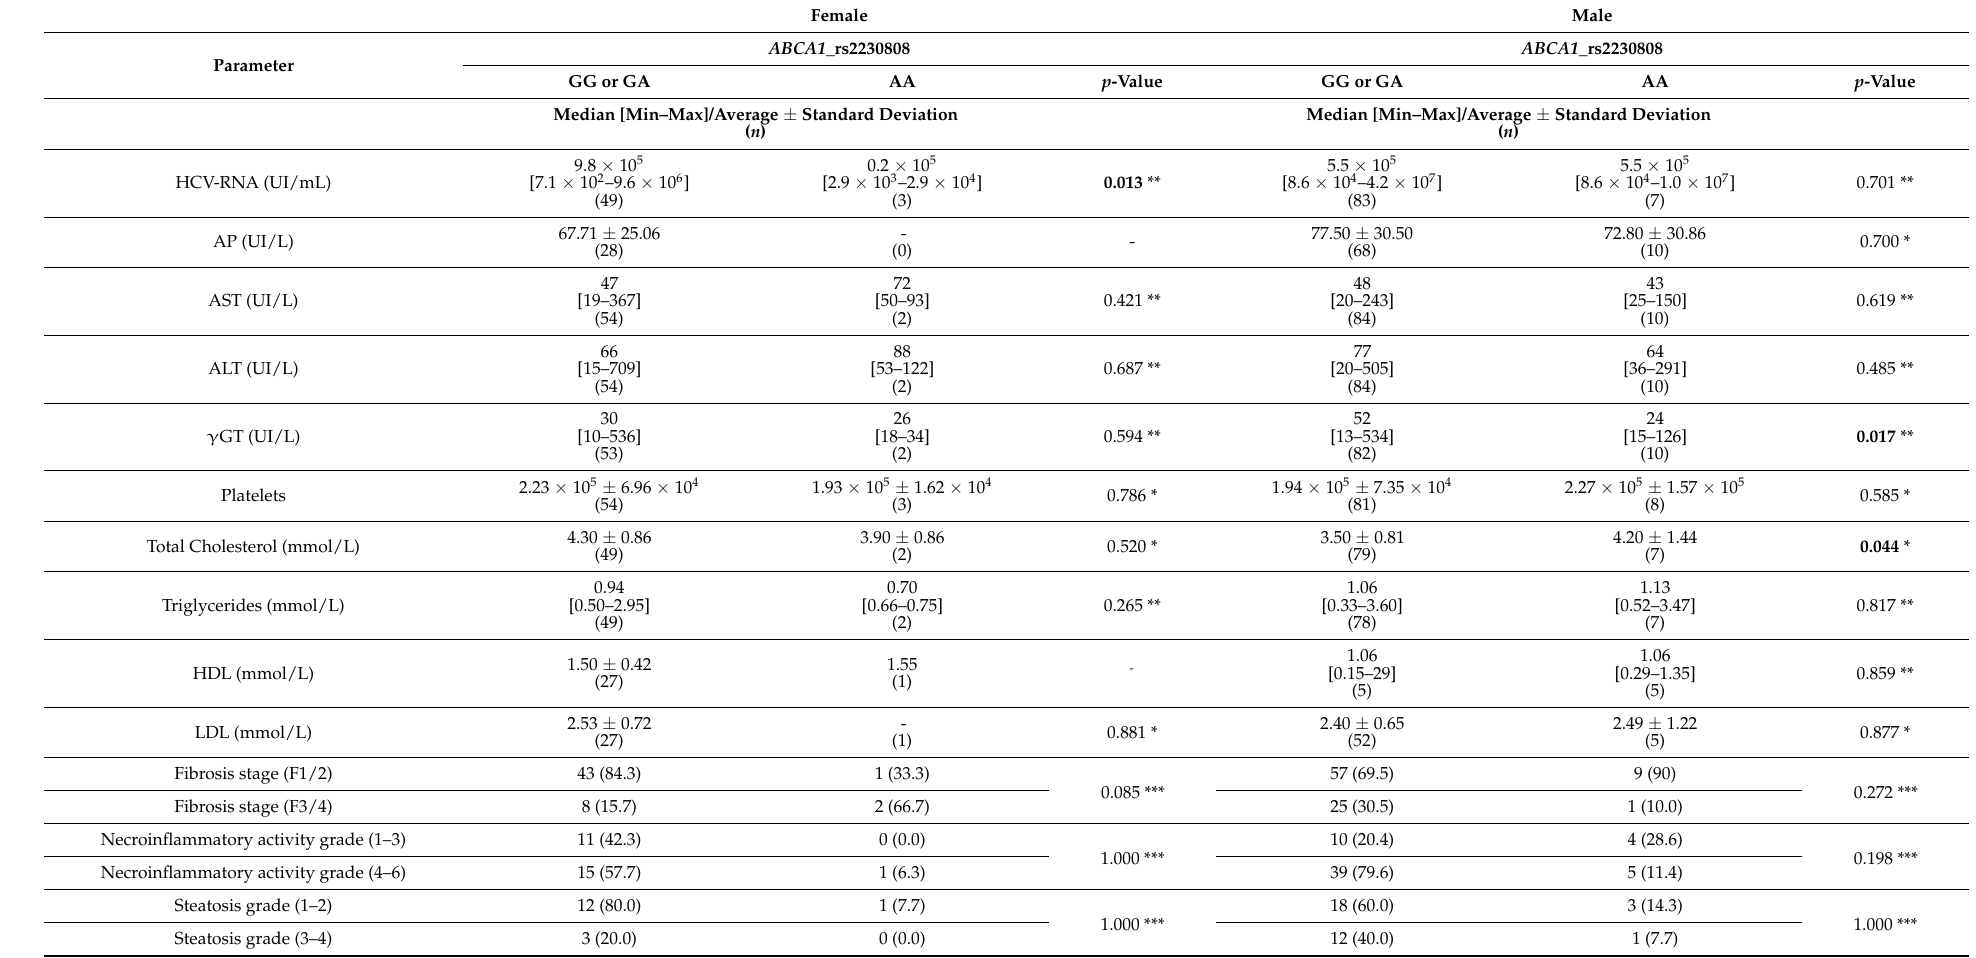
Table 3. Association of ABCA1 _rs2230808 with biochemical and histological parameters; dominant model (GG or GA vs.